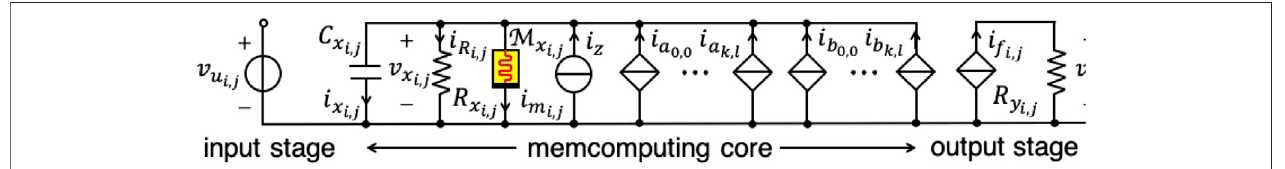
(cid:1) C M (cid:1) M (cid:1) R (cid:1) R x , x i , j x , R x i , j x , and R x i , j y . Two are the main contributions i , j